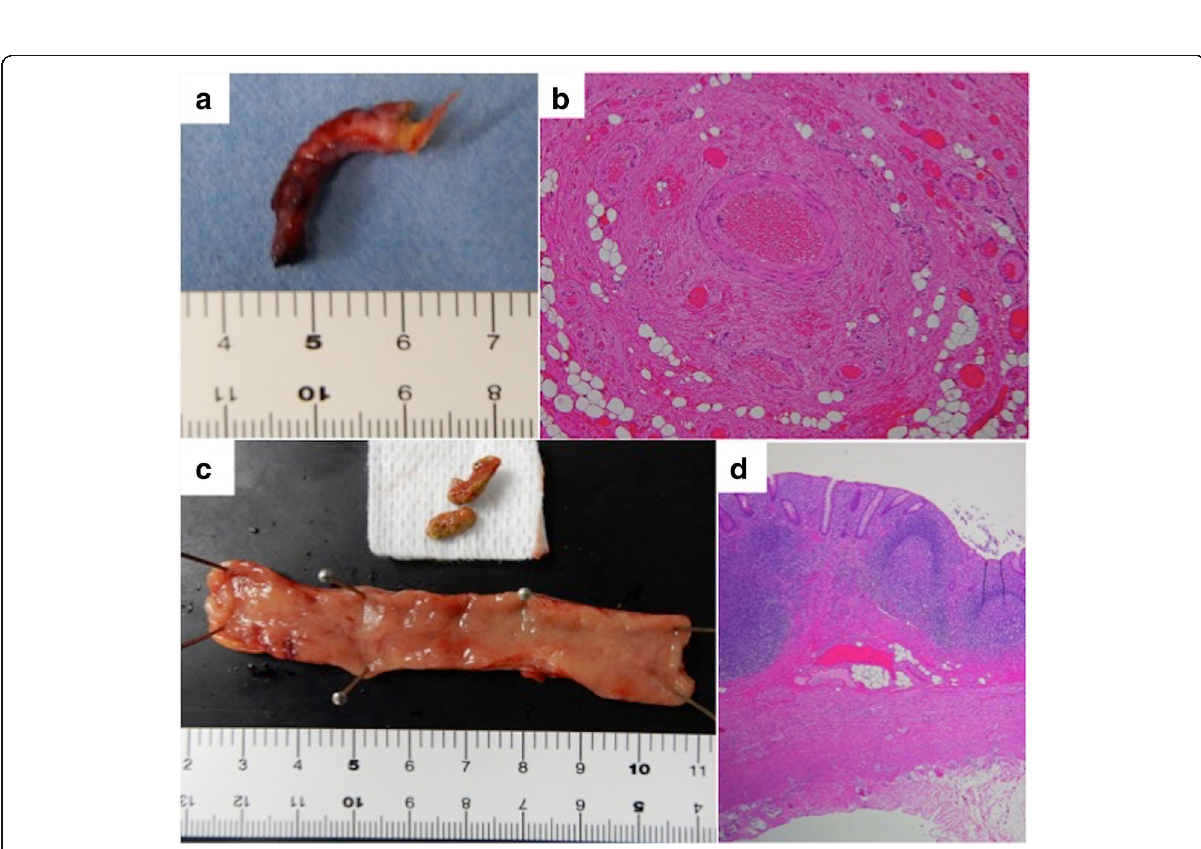
Fig. 3 Macroscopic and pathological findings of the resected specimens. a Macroscopic findings of the band. b Microscopic examination revealed that the band consisted of blood vessels. c Macroscopic findings of the appendix. The appendiceal wall was slightly thickened, and fecal stones were found on the proximal side of the appendix. d Microscopic examination revealed diffuse infiltration of lymphocytes and eosinophils throughout the muscularis